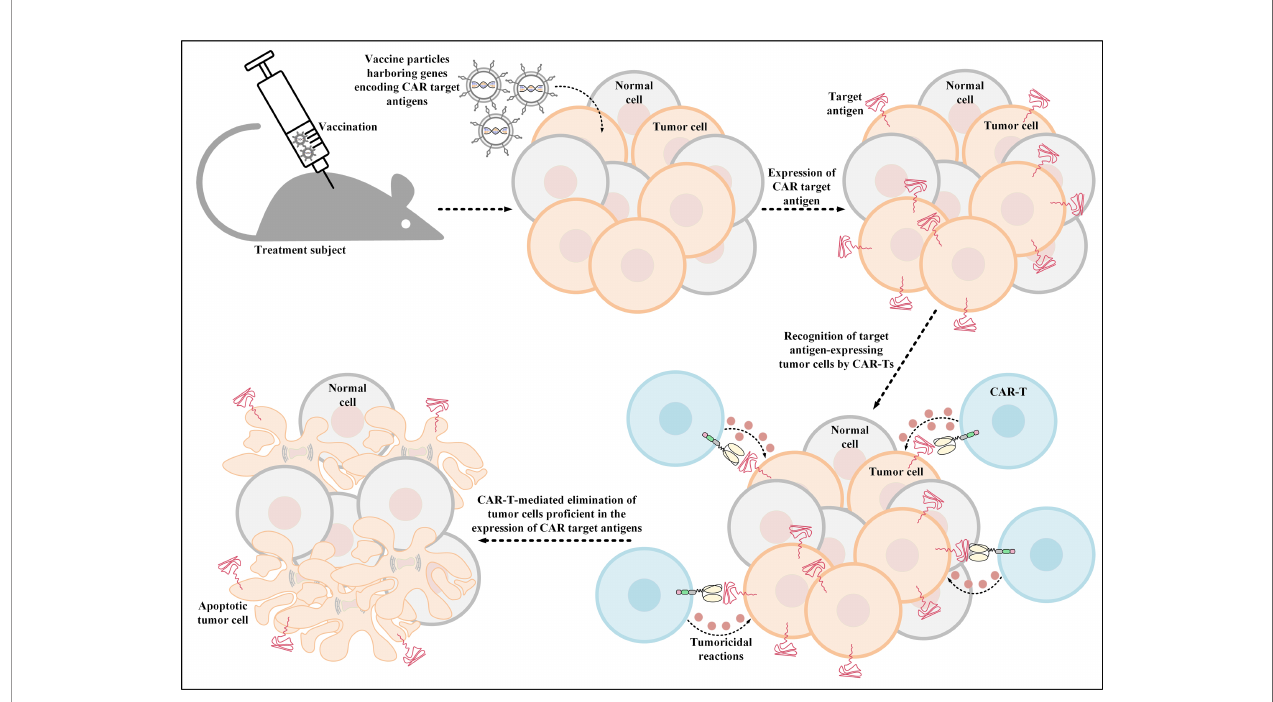
FIGURE 3 | Oncolytic vaccinia virus-mediated induction of CAR target antigen expression. This type of induced CAR target antigen expression in tumor cells results in ef fi cient recognition and elimination of target antigen-expressing tumor cells by CAR-Ts. CAR; chimeric antigen